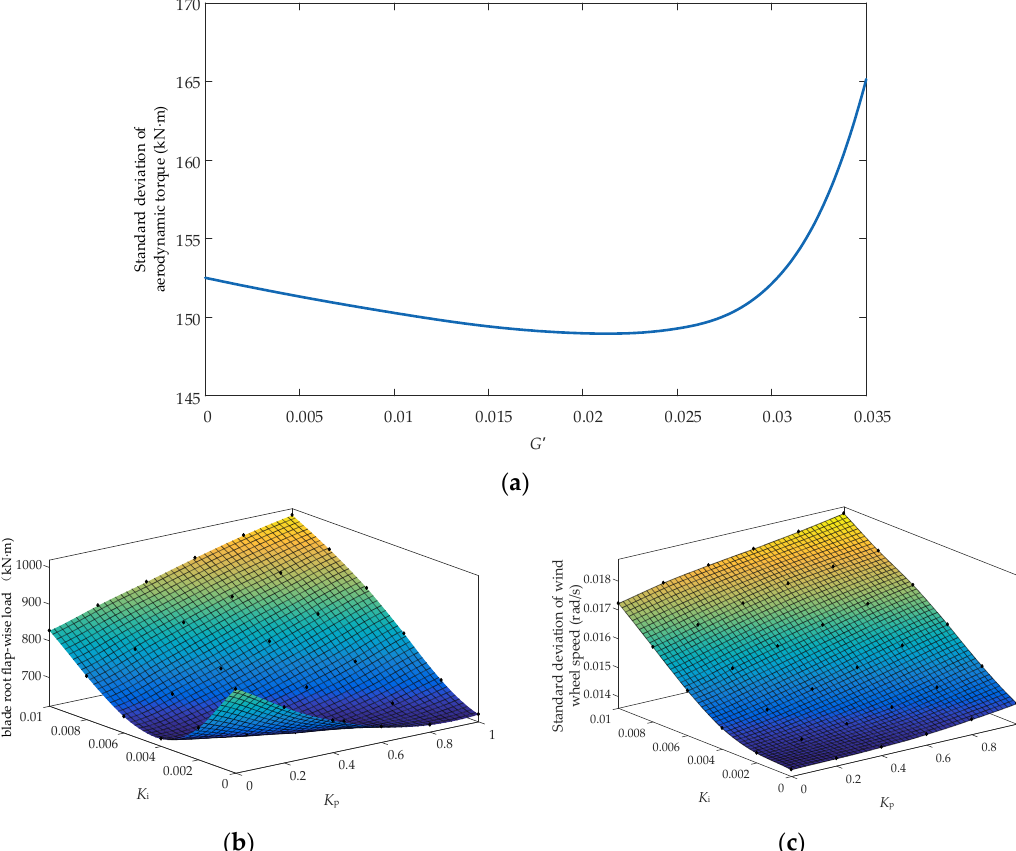
Figure 11. Control performance with different pitch control parameters under random wind-wave conditions: ( a ) Standard deviation of aerodynamic torque at different ' G ; ( b ) Standard deviation of blade root flap-wise load at different K p , K i ; ( c ) Standard deviation of wind wheel speed at different K p , K i .